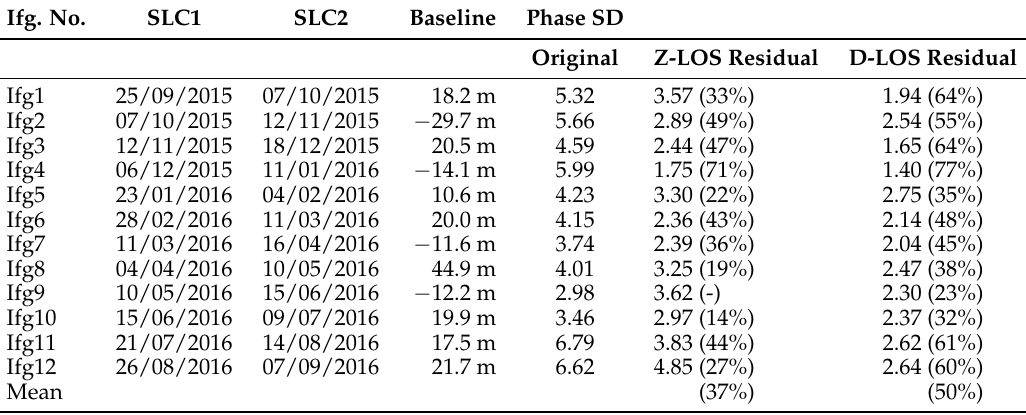
Table 1. Statistical comparison of different mitigation methods for 12 Sentinel-1 interferograms used in the Tenerife island. Values in parentheses are the correction percentage of (original-residual)/original. Ifg,